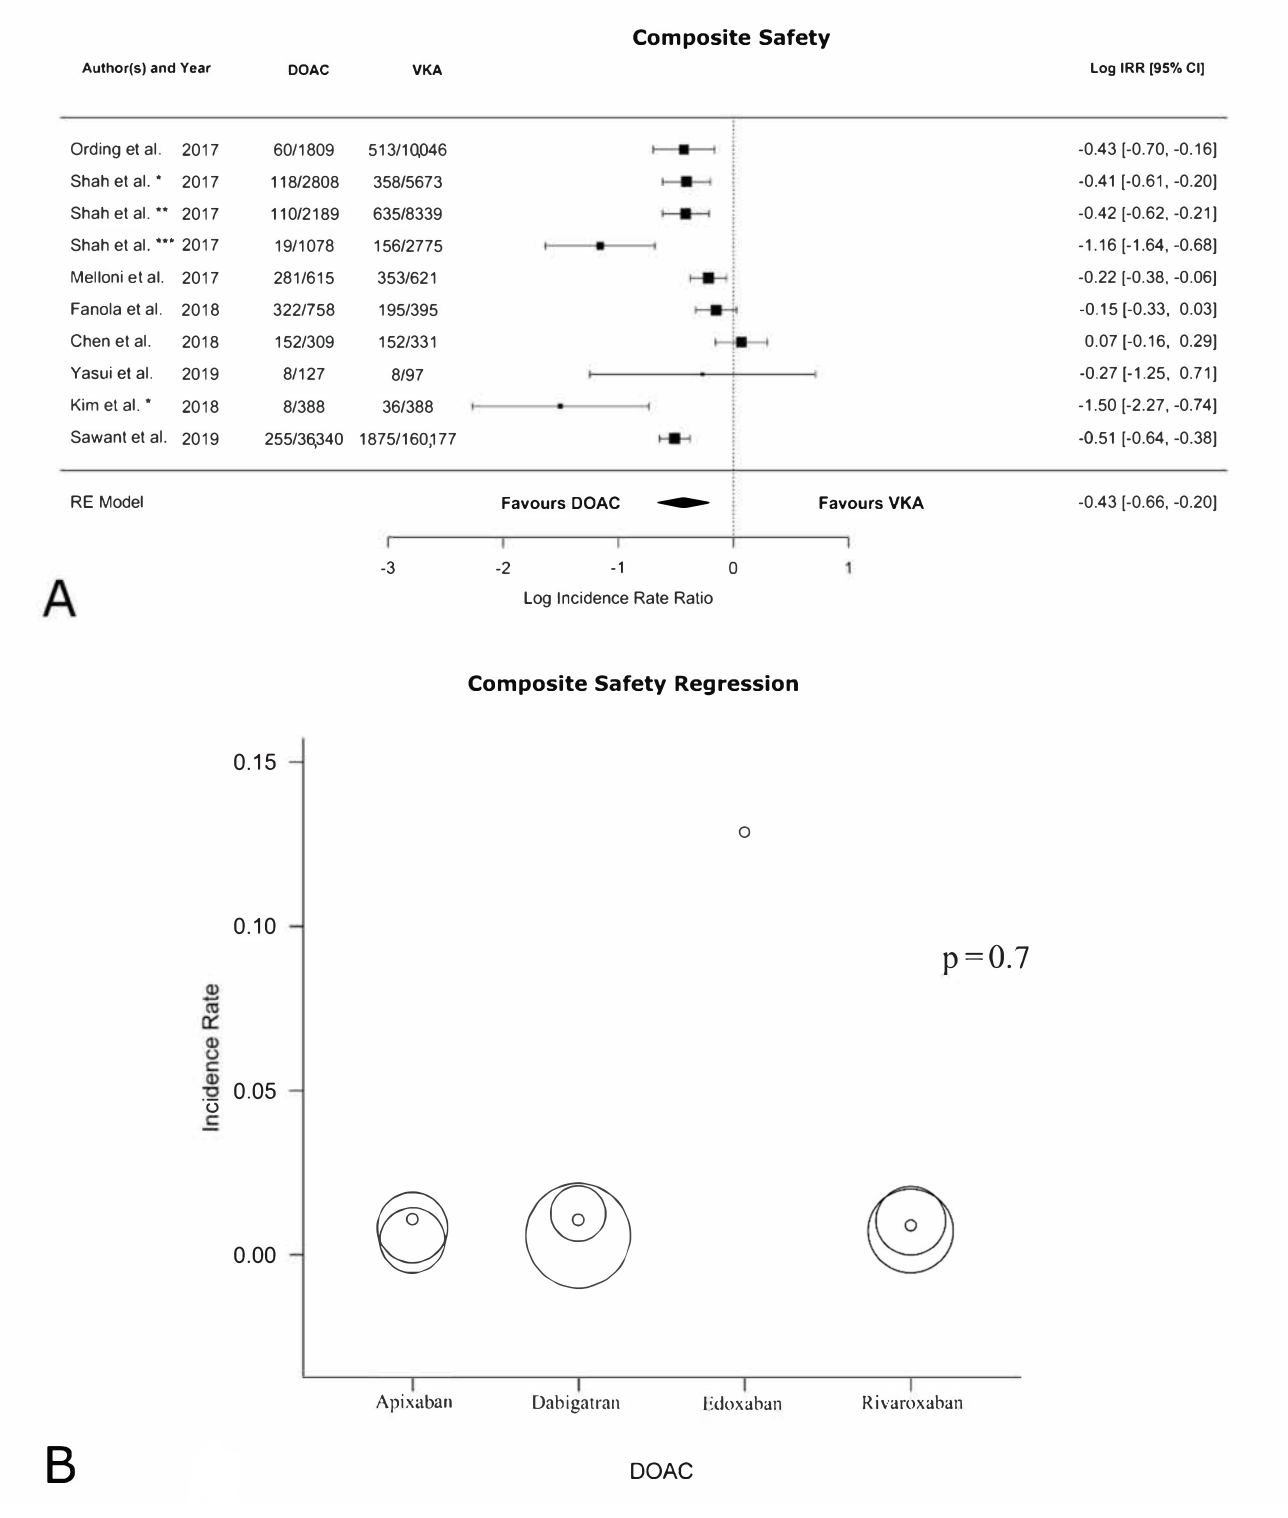
Figure 2. ( A ). Safety outcome composite. Forest plot of the IRR in VKAs versus DOACs. ( B ). Composite safety regression * rivaroxaban, ** dabigatran, *** apixaban